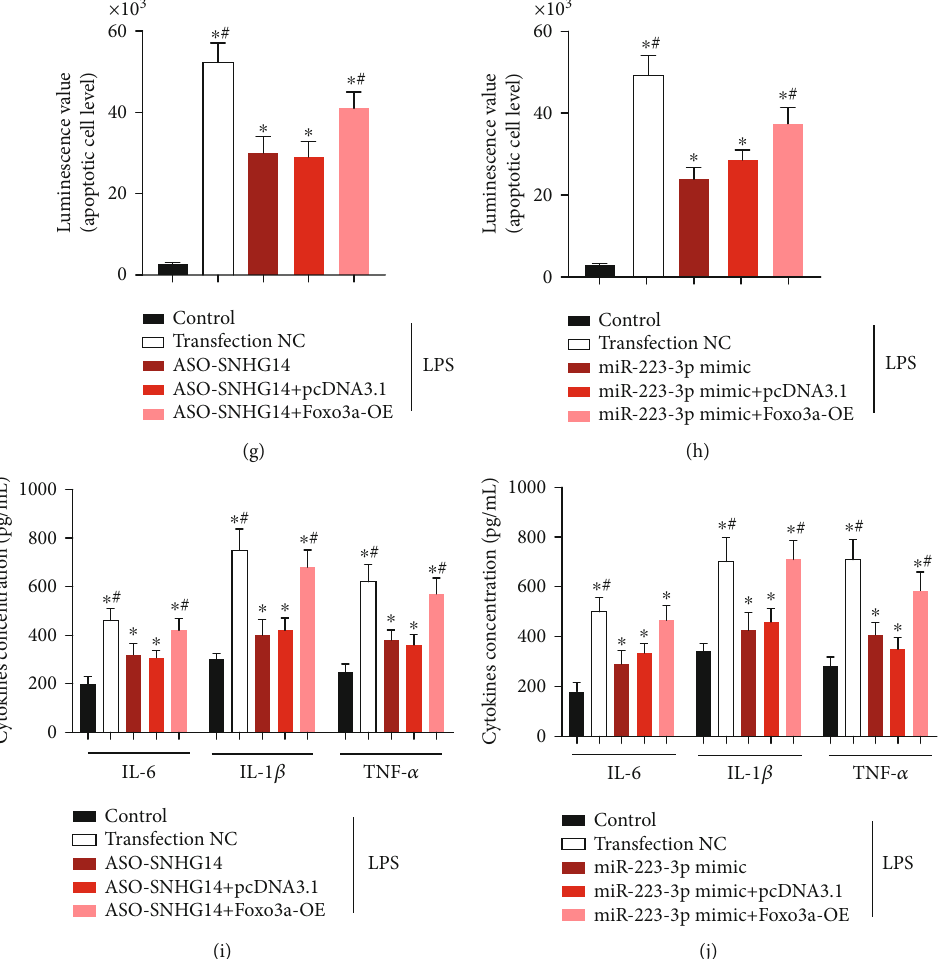
Figure 4: lncRNA-SNHG14/miR-223-3p/Foxo3a axis participated in LPS-induced A549 cells injury. A549 cells were transfected with pcDNA3.1-SNHG14, pcDNA3.1-SNHG14+ siRNA-Foxo3a, miR-223-3p, and miR-223-3p +siRNA-Foxo3a, respectively. Cell viability was detected using CCK-8 kit at 0, 24, 48, and 72 h (a, b). The apoptosis level of cells in each group was measured using RealTime-Glo ™ Annexin V dye. Luminescence was detected using a fl uorescence plate reader to indicate apoptosis (c, d). Cells were transfected with ASO-SNHG14, ASO-SNHG14+pcDNA3.1-Foxo3a, miR-223-3p mimic, and miR-223-3p mimic+pcDNA3.1-Foxo3a, respectively. Cell viability (e, f), apoptotic cells (g, h), and cytokine level changes (i, j) were detected under LPS treating condition. ∗ P < 0 : 05 compared with transfection negative control mix or LPS untreated control. # P < 0 : 05 compared with cells without cotransfection of siRNA-Foxo3 or